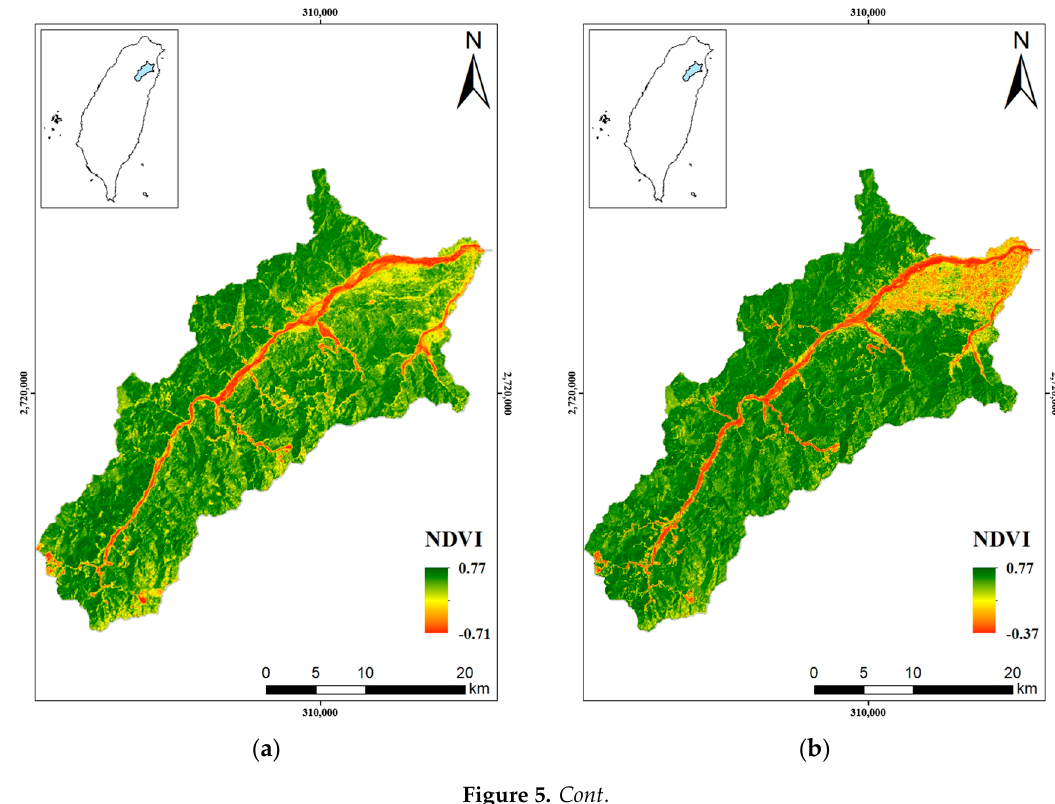
Table 5. Normalized Difference Vegetation Index (NDVI) difference of the Lanyang River